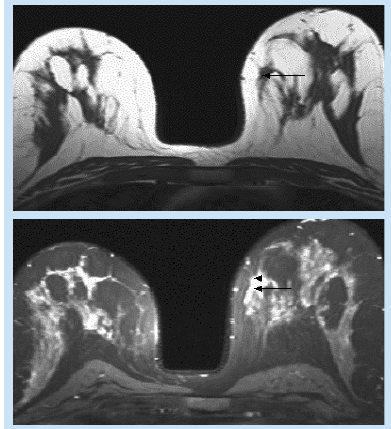
Fig 2a,b. Patient with a breast cancer involving the medial aspect of the breast (arrow) is more conspicuous on the fat-saturated T1 STIR post- contrast